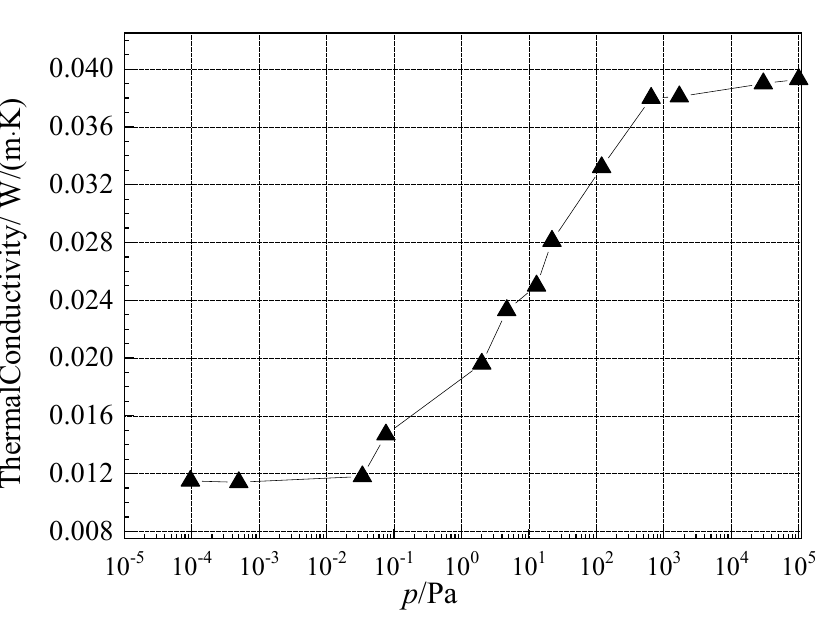
Figure 4. Thermal conductivity of extruded plastic panel samples under different vacuum levels.